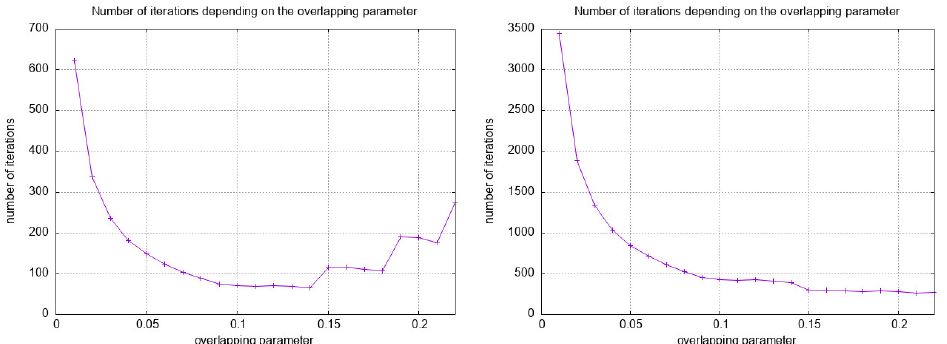
Figure 3. Number of iterations depending on the overlap parameter: damping parameter associated with the color ( left ) and constant damping parameter ( right ).